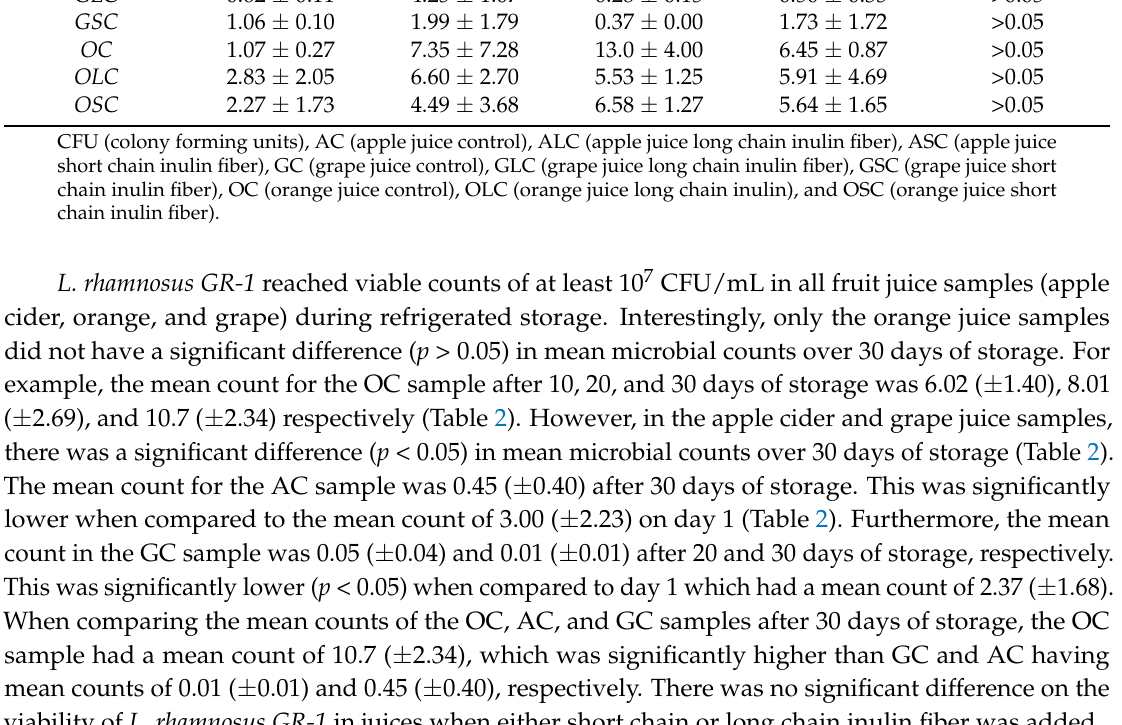
Table 2. Viable counts (Mean ± SD) of L. rhamnosus GR-1 in probiotic non-dairy fruit juices fortified with inulin fiber after 1, 10, 20, and 30 days of refrigerated